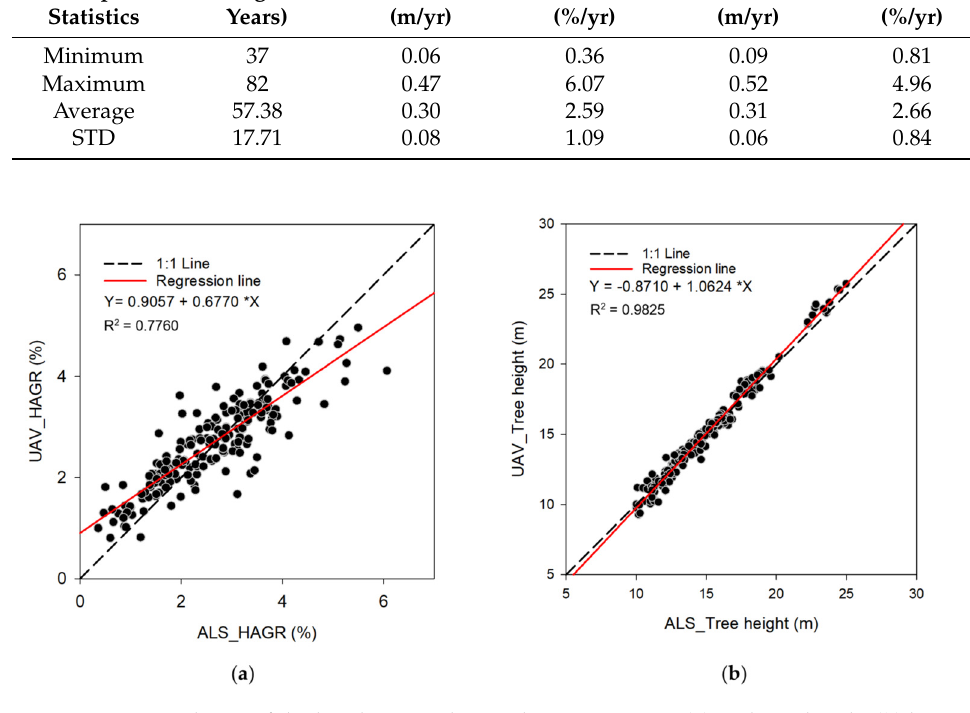
Table 9. Height annual growth rate of the Hinoki trees over a wide range of stand ages. Descriptive